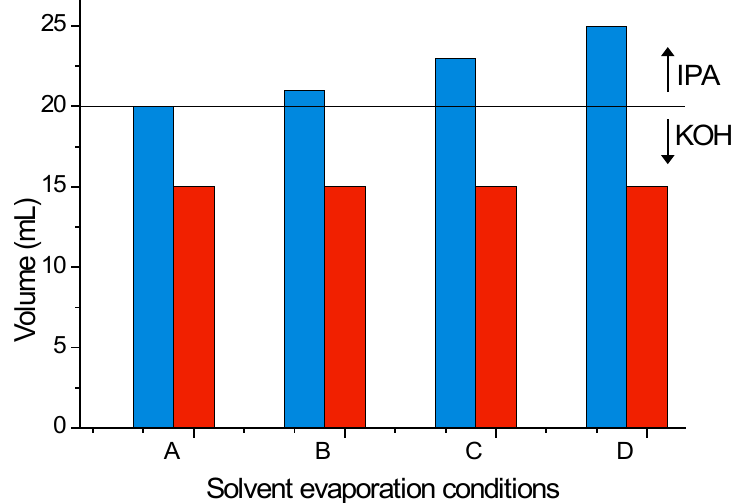
Figure 3. Graphical representation of the total initial volume (blue), as sum of initial KOH volume (20 mL) and IPA volume (0 to 5 mL), versus the final volume (red) after a total etching time of 120 min. Table 1. Experimental conditions used in the definition of 10 μm × 10 μm wide pyramid structures through wet etching. IPA availability represents the predicted time at when all IPA would